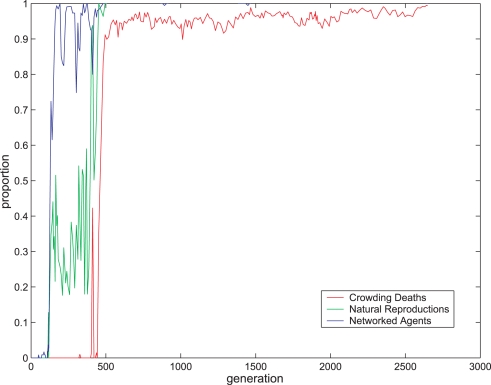
Evolution in behavioral experiment.Green: Proportion of reproduction triggered by virtual organisms contacting each other (as opposed to reproductions initiated by the system when the number of virtual organisms hit the lower bound). Blue: Proportion of virtual organisms that developed a basic network as defined in the text. Red: Proportion of virtual organism death events triggered by the system because of crowding (as opposed to deaths due to completing the life span period). The values are average proportions measured every 10 generations.